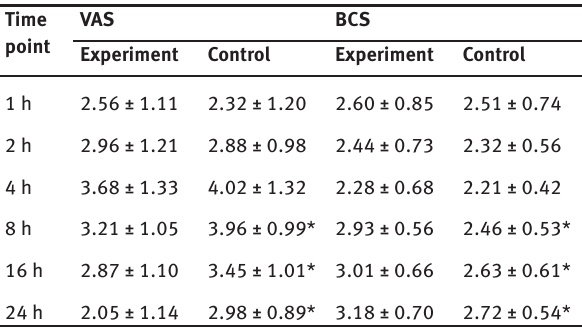
Table 2: VAS and BCS score of the two groups ( sx ±